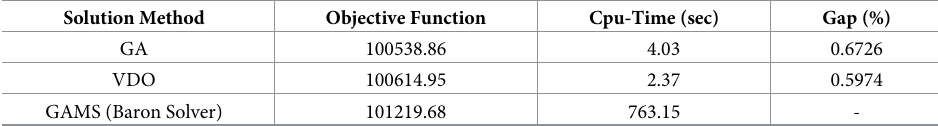
Table 8. The comparison of the exact and metaheuristic algorithms for the small-sized test